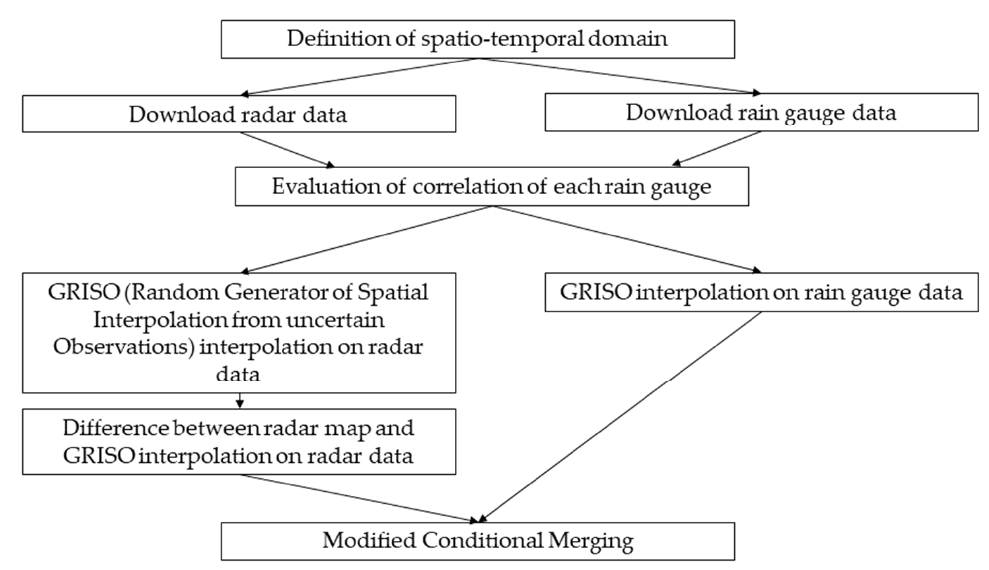
Figure 3. MCM Figure 3. MCM workflow.